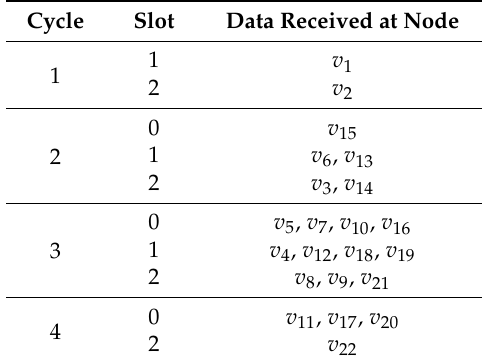
Table 4. Data packet dissemination using AAS-LBR.